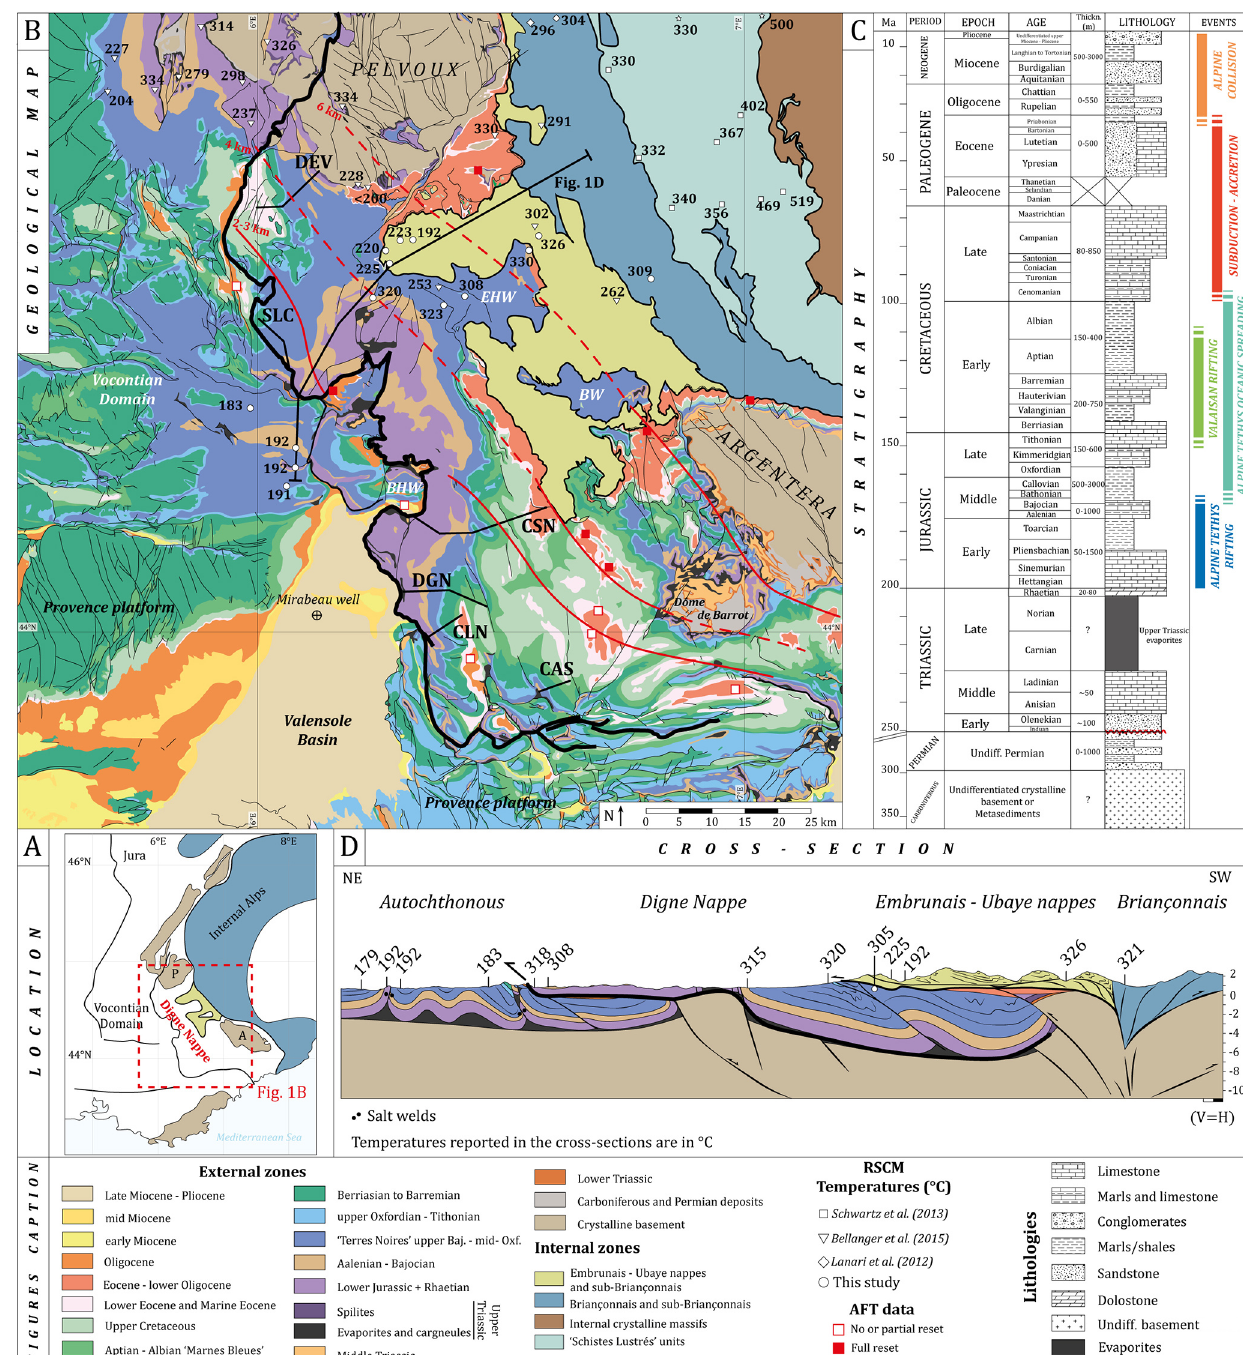
Figure 1. (a) Location of the study area in the regional framework of the Western Alps. (b) Simplified geological map of the SW Alps with the position of the sampled stratigraphic sections, 15 original RSCM temperatures and RSCM temperatures from the literature (Schwartz et al., 2013; Lanari et al., 2012), modified from the Bureau de Recherches Géologiques et Minières (BRGM) geological maps at 1 / 250000. The sections from NNW to SSE are the following. DEV: Devoluy; SLC: La Saulce; CSN: Cousson; DGN: Digne; CLN: Coulnier and CAS: Castellane. Red lines are reconstructed isopaches of Cenozoic foreland deposits based on published apatite fission-track data (Labaume et al., 2008; Jourdan et al., 2013; Schwartz et al., 2017). BHW: Barles Half Window; BW: Barcelonnette Window and EHW: Embrun Half Window. (c) Simplified synthetic stratigraphic column of the area, modified from Célini et al. (2022). (d) Cross-section through the northern part of the Digne Nappe and the Embrunais–Ubaye nappes containing temperatures from this study. See location in (b) .